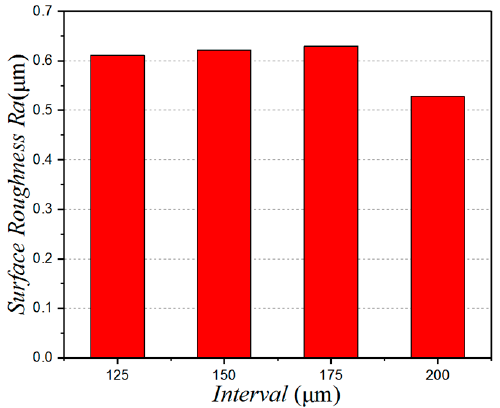
Figure 8. The relationship between the depth and the surface roughness.